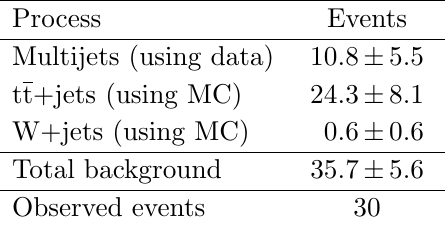
Table 3 . Estimated background and the number of observed events in the signal region after all selection criteria. The combined statistical and systematic uncertainty is shown.